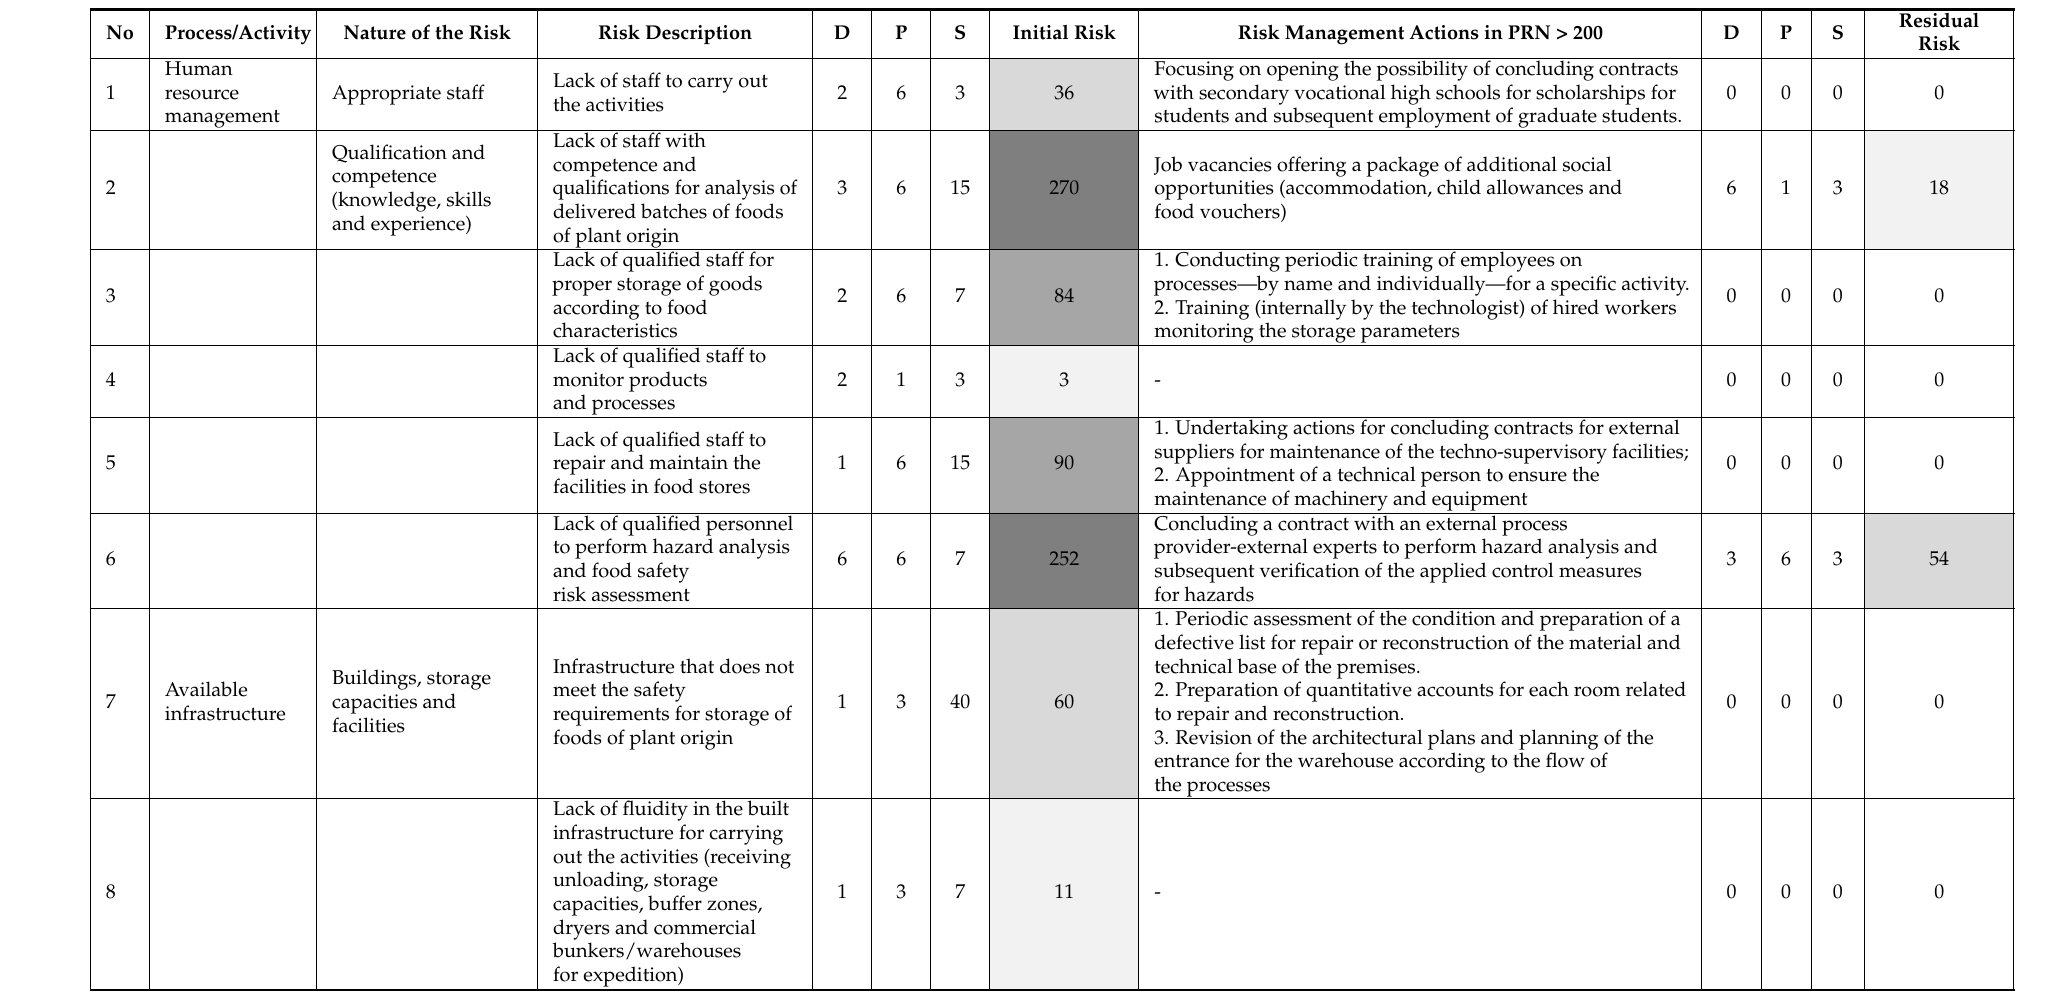
Table 1. Risk assessment for the storage of food of plant